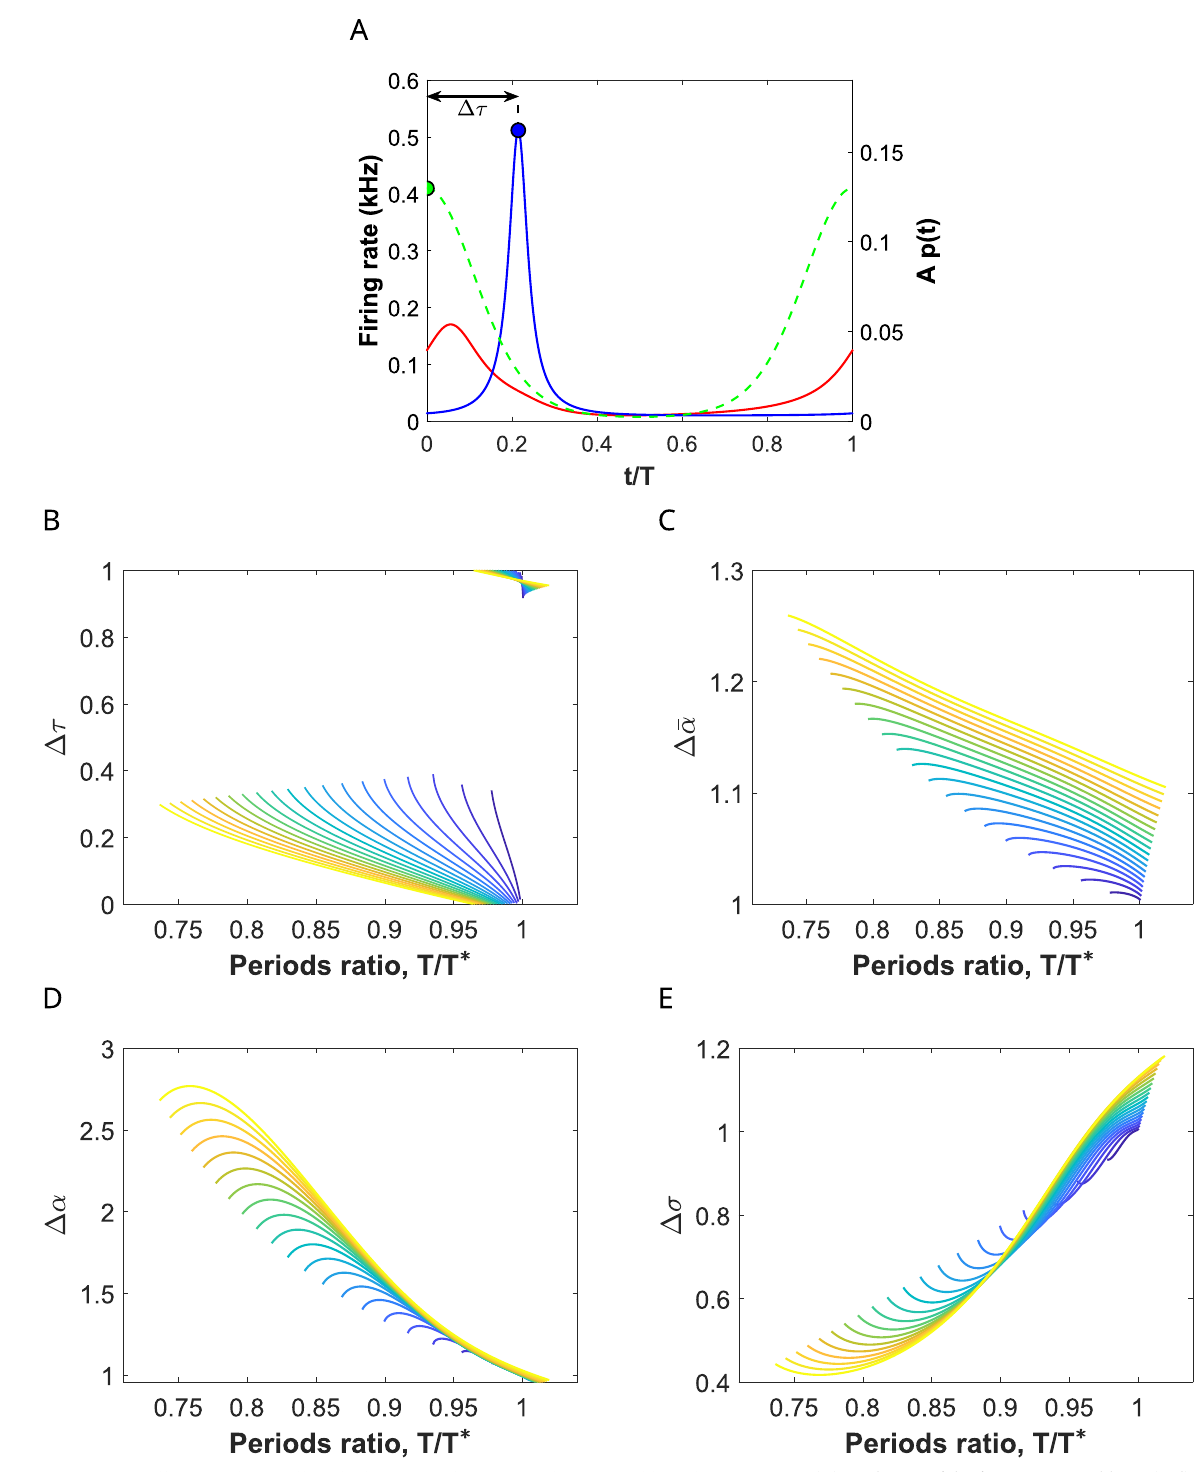
Fig 4. Input effects on the E-cell evoked response for a network entrained by coherent inputs. (A) Evolution of the firing rate variables r and r i (blue) of the perturbed system (1)-(2) with a von Mises input with κ = 2 (dashed green) for a representative periodic orbit within the 1:1 phase-locking region. (B-E) Factors describing changes in the E-cell response within this phase-locking region for orbits of the perturbed system (1)-(2) calculated along (equidistant) sections A = ct of the corresponding Arnold tongue, indicated by the color of the curve (ranging from dark blue, A = 0.01, to yellow, A = 0.2, with increments of size 0.01). The factors are: (B) Δ τ , describing the timing between inhibition and input volleys (normalized by the input period T ), (C) D � a , describing the rate change in the averaged firing rate of the E cells, (D) Δ α , describing the rate change in the maximum of the firing rate of the E cells, and (E) Δ σ , describing the rate change in E-volley half-width. See Methods. https://doi.org/10.1371/journal.pcbi.1009342.g004 PLOS Computational Biology | https://doi.org/10.1371/journal.pcbi.1009342 May 18,